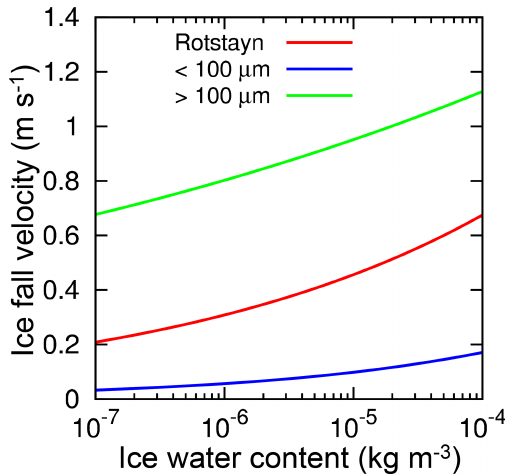
Figure 14. Ice sedimentation velocities (ms − 1 ) of Rotstayn (1997) (Eq. 1, red line), derived for particles smaller than 100µm (Eq 3, blue line) and for particles larger than 100µm (Eq. 4, green line). The horizontal axis shows ice water mass density ρ a q i (kgm − 3